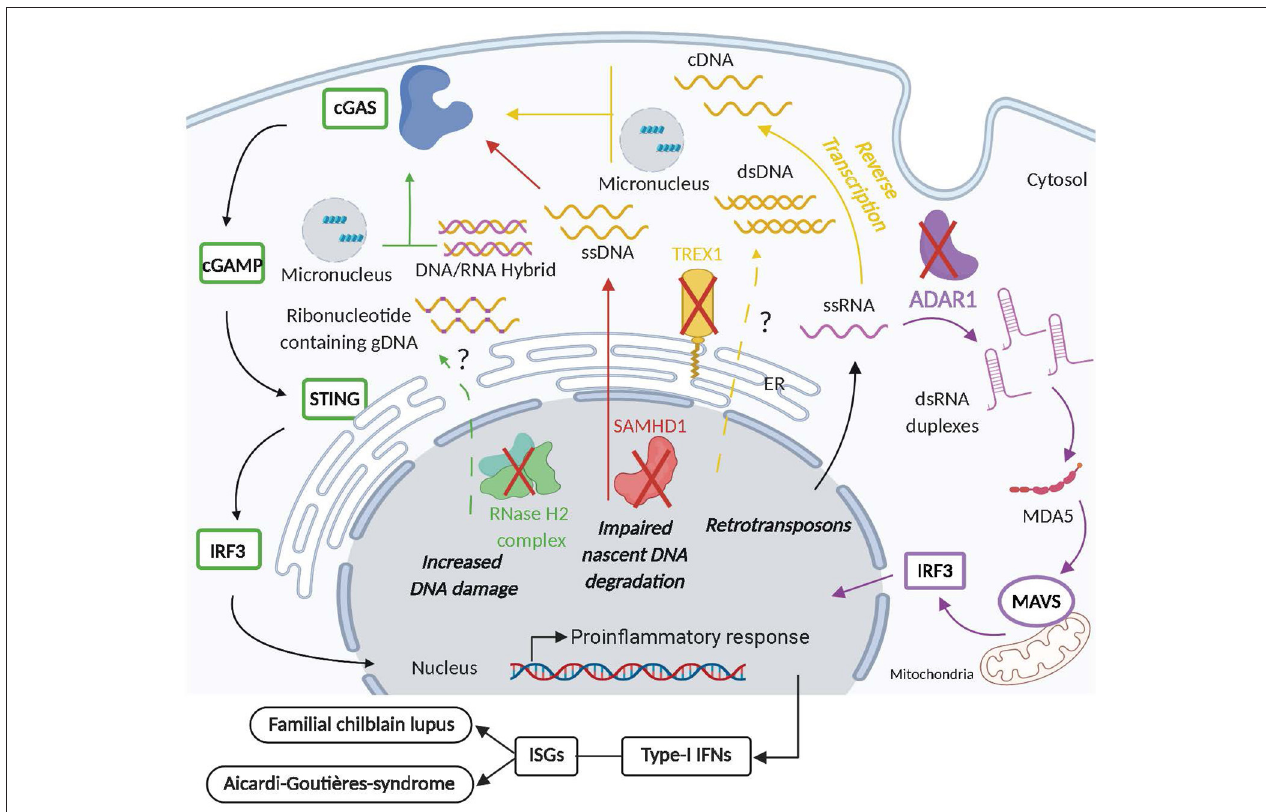
FIGURE 4 | Intracellular nuclease and NA-editing enzyme deficiency aberrantly activates inflammatory and autoimmune responses. Mutations in TREX1 (yellow) that affect its exonuclease activity or cause its deficiency, lead to the cytosolic accumulation of ssDNA originating from the reverse transcription of endogenous LTR-retrotransposons that activate the cGAS/STING pathway causing the secretion of pathogenic type-I interferons (IFN-I) and the development of familial chilblain lupus (FLC) and Aicardi Goutières Syndrome (AGS). Furthermore, dsDNA and micronuclei may be detected in the cytosol of individuals with dysfunctional TREX1 and contribute the aberrant activation of the cGAS/STING pathway as well. Mutation in SAMHD1 (red) causes the release of ssDNA from stalled replication forks that stimulates IFN-I production upon the activation of the cGAS/STING pathway that may ultimately contribute to AGS and FCL. AGS is also associated with mutations in RNase H2 complex (green) that reduces ribonucleotide excision repair (RER) and thus increases DNA damage and possibly the release of DNA:RNA hybrids, micronuclei and ribonucleotide containing gDNA into the cytosol that may activate cGAS/STING-mediated production of deleterious IFN-I. Finally, dysfunction in ADAR1 (purple) leads to the accumulation of dsRNA duplexes originating from endogenous retrotransposon RNA in the cytosol which upon activation of the MDA5 pathway causes the secretion of pathogenic IFN-I responsible for AGS